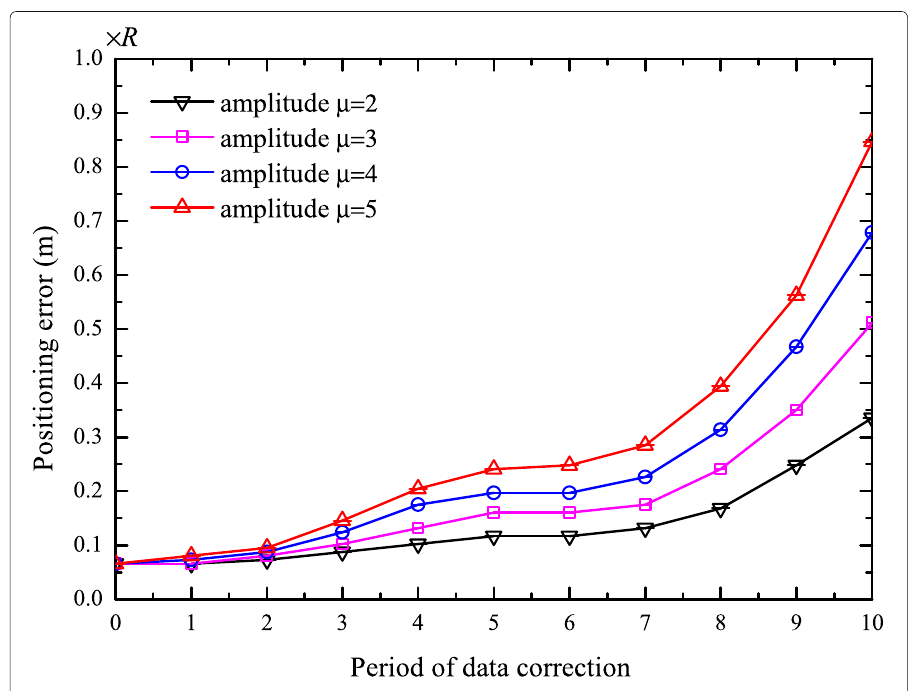
Fig. 7 Change of positioning error with current amplitude during 10